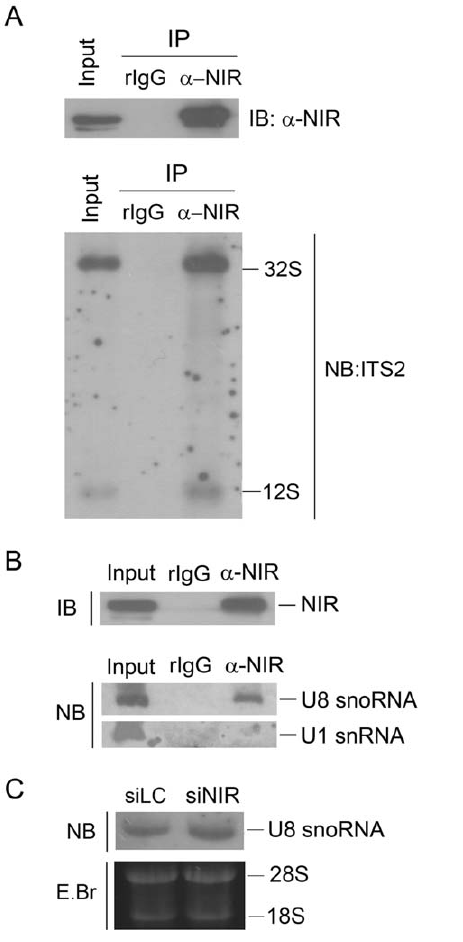
Figure 4. NIR is associated with 32S and 12S pre-rRNAs and U8 snoRNA in vivo and knock down of NIR did not affect U8 snoRNA. A. Immunoprecipitation was performed with anti-NIR antibody on U2OS cell lysates, protein and RNA were prepared in parallel. Proteins were separated on SDS-PAGE, blotted onto a PVDF membrane and subjected to Western blotting analysis probed with anti-NIR (upper panel). Ten percent of cell lysates were loaded as input control. RNA extracted from the immunoprecipitation was resolved on 1% agarose-glyoxal gel and blotted onto a nylon membrane. Blot was probed with biotin-labeled ITS-2 oligonucleotide (lower panel). B. Immunoprecipitation was performed with anti-NIR antibody and proteins from the immunoprecipitation were subjected to Western blotting analysis probed with anti-NIR as described in A (upper panel). Ten percent of cell lysates were loaded as input control. RNA extracted from the immunoprecipitation was resolved on 7% polyacrylamide/ 8.3 M urea and blotted onto a nylon membrane. Blot was probed with biotin-labeled U3 snoRNA-specific RNA probe or U1-specific RNA probe (lower panel). RNA extracted from 2.5% cell lysates were loaded as input control. C. U2OS cells were transfected with NIR specific siRNA (siNIR) or a siRNA targeting luciferase (siLC) as a control. Seventy-two hours post transfection, total RNA was extracted. Equal amount RNA was resolved on a 7% polyacrylamide–8.3 M urea gel and transferred onto a nylon membrane. Blot was hybridized with U8 snoRNA specific probe.